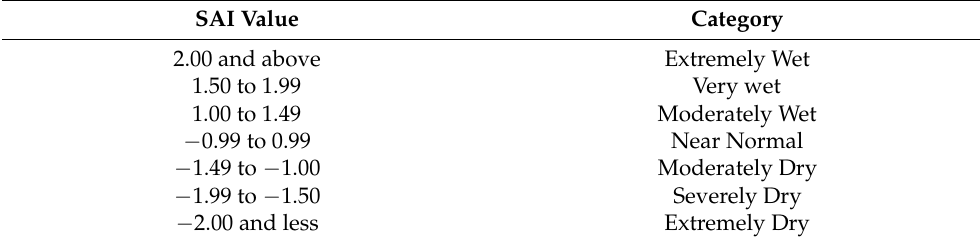
Table 1. Classifications of